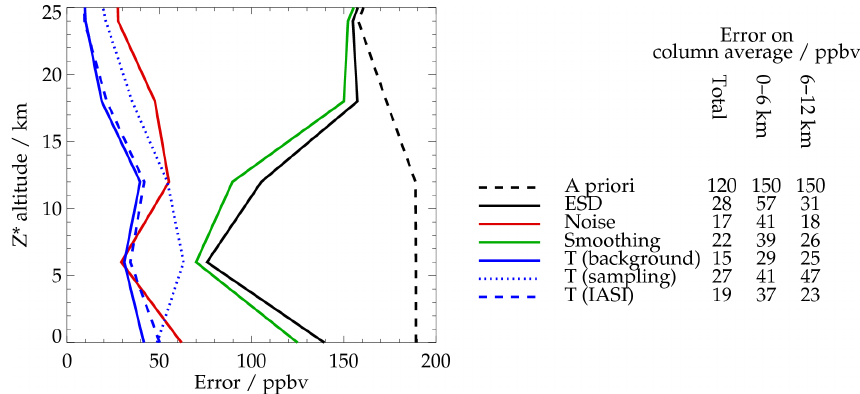
Figure 2. Estimated errors for the methane profile (in panel) and column average (indicated in